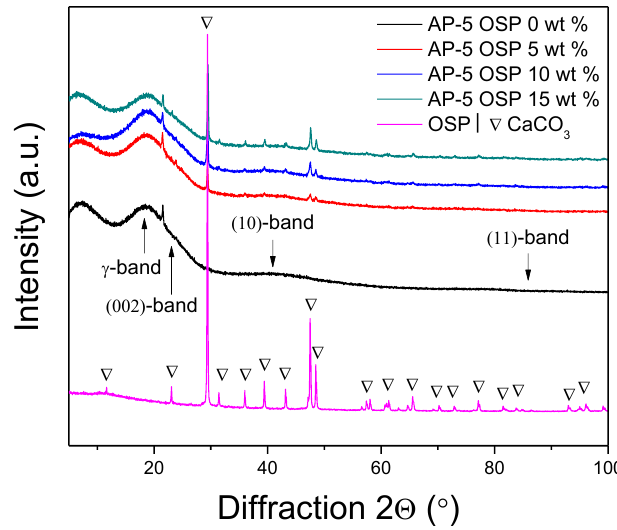
Figure 5. XRD patterns of OSP, neat asphalt, and OSP-filled asphalts.